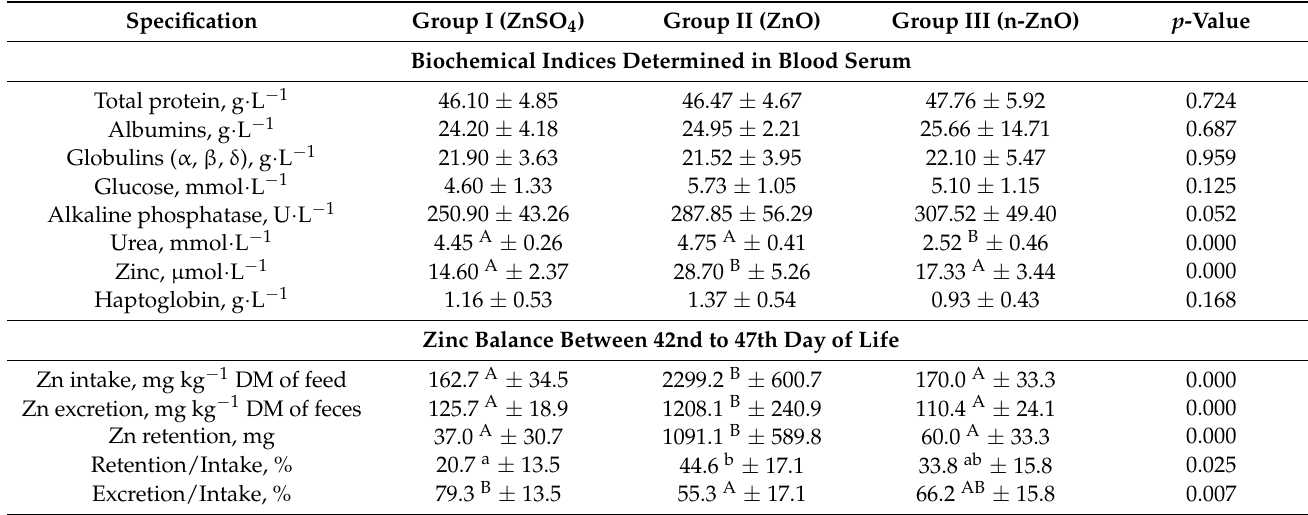
Table 4. Laboratory results and zinc